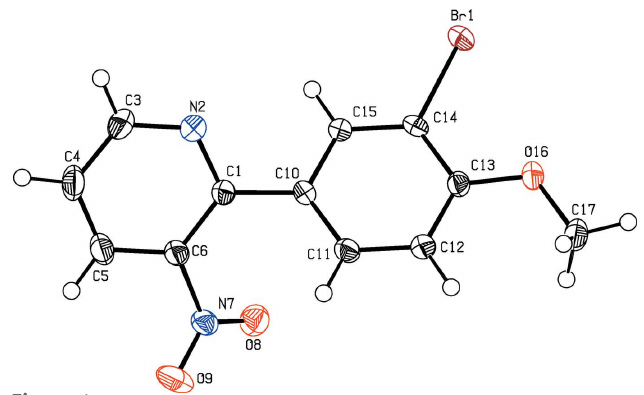
Figure 1 View of the title compound. Displacement ellipsoids are drawn at the 50% probability level.